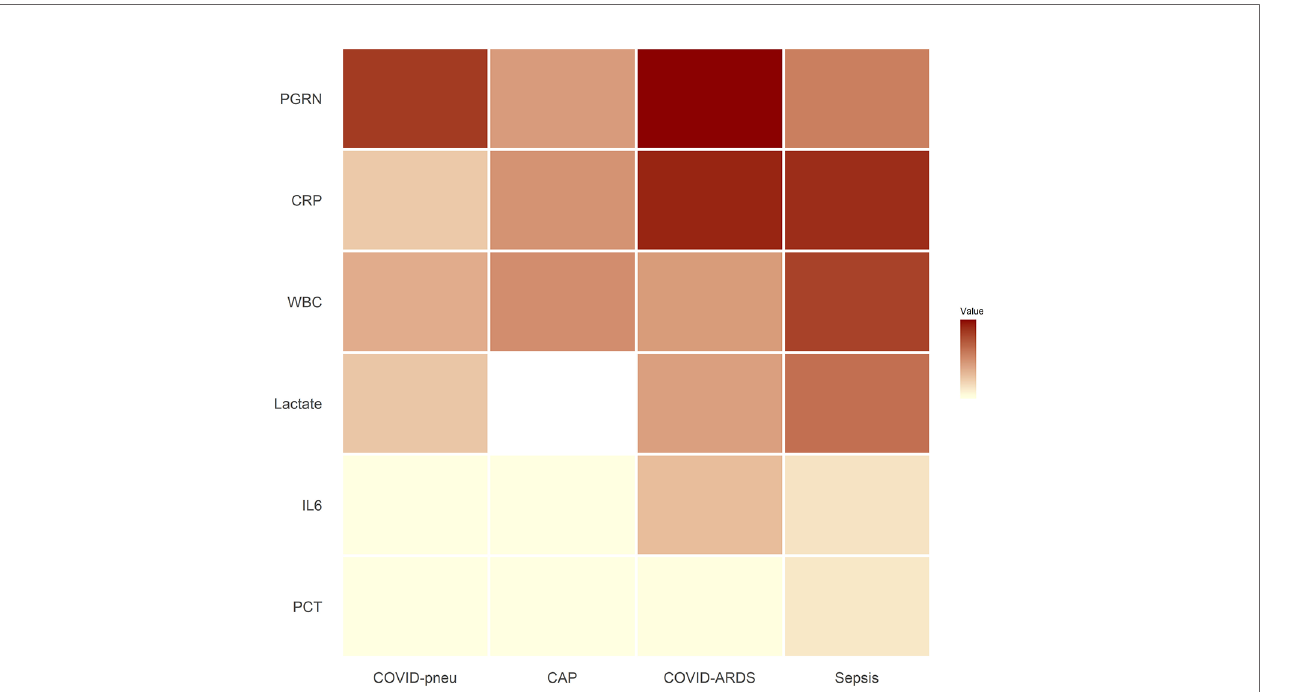
FIGURE 1 | Heat map of in fl ammatory parameters of patient groups (medians). Outliers were set to the maximum of the remaining values. For community acquired pneumonia, no serum lactate was available. All associated numerical values and statistical comparisons of laboratory results between groups are presented in Table 3 . PGRN, progranulin; CRP, C-reactive protein; WBC, leukocyte count; Lactate, serum lactate; IL6, interleukin-6; PCT, procalcitonin; COVID-pneu, COVID-19 pneumonia; CAP, community acquired pneumonia of bacterial origin; COVID-ARDS, COVID-19 acute respiratory distress syndrome; Sepsis, sepsis-related acute respiratory distress